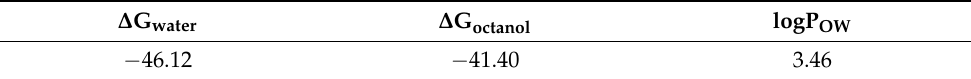
Table 8. ∆ G water , ∆ G octanol the Gibbs energies of solvation in water and octanol [kcal/mol]. logP OW —the octanol/water partition